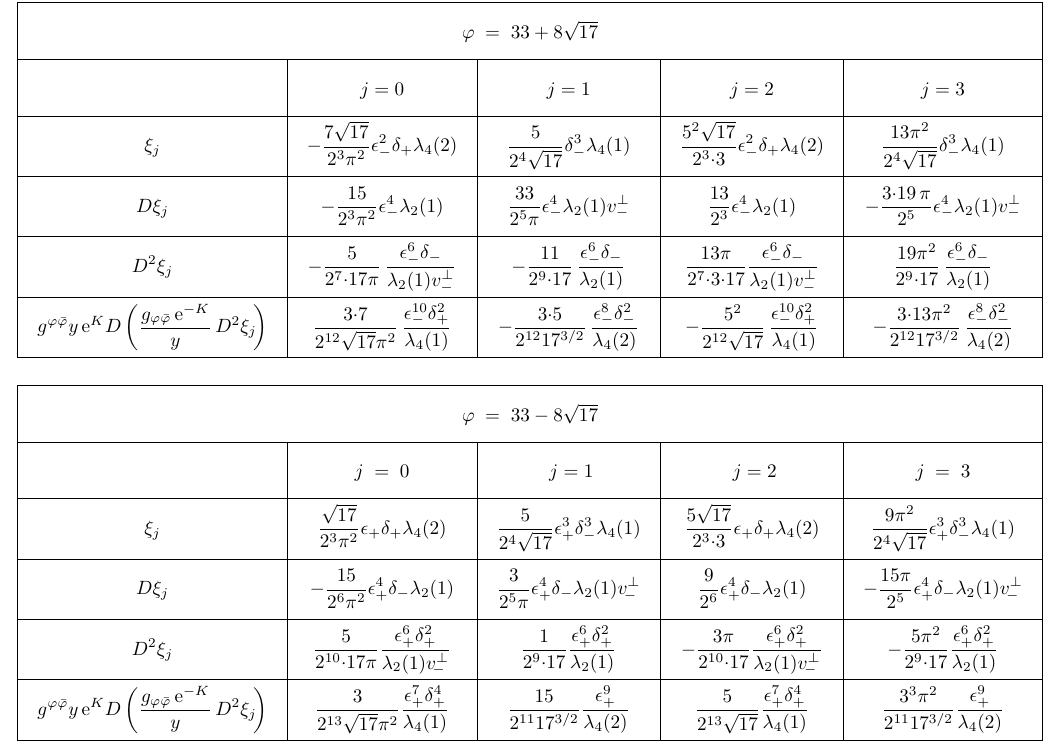
Table 8 . The values of the (cid:24) j and their (cid:12)rst three covariant derivatives.